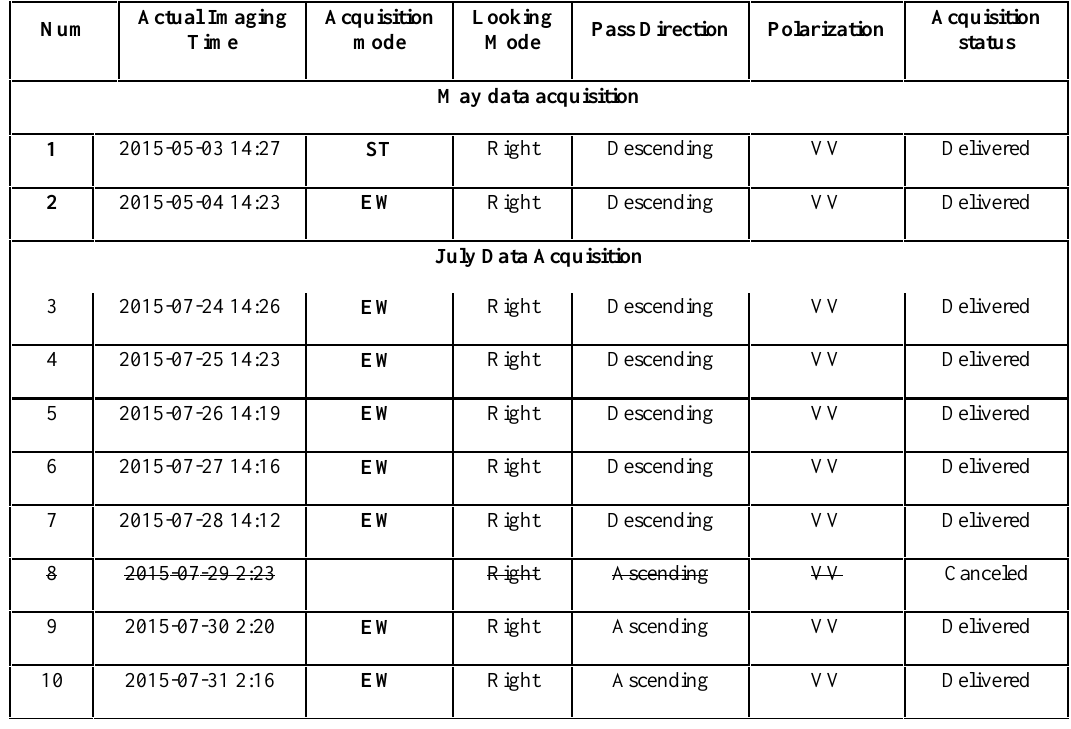
Table 1: list of KompSAT-5 data and their characteristics and UTC time